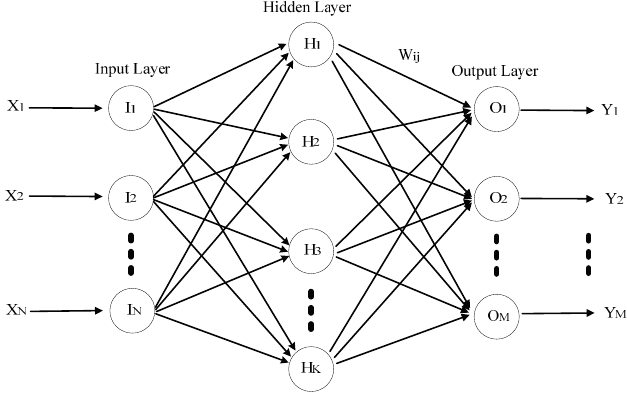
Figure 4. The structure of an RBF